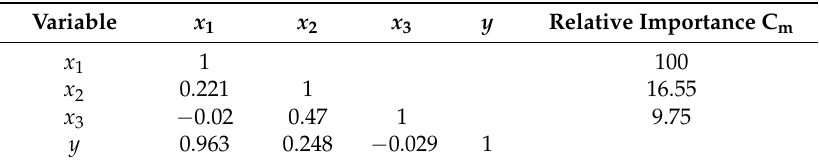
Table 6. Relative importance of variables and their